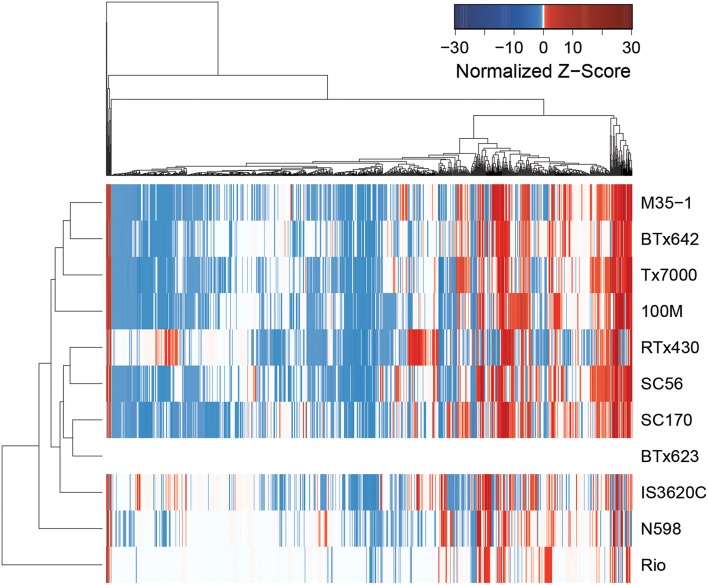
Z-scores of metabolite abundance. The relative abundance of each cluster (metabolite) in each line is normalized to line BTx623 (in which z-scores are set to zero and shown in white). Increased abundance relative to control is shown in red and decreased abundance is shown in blue.